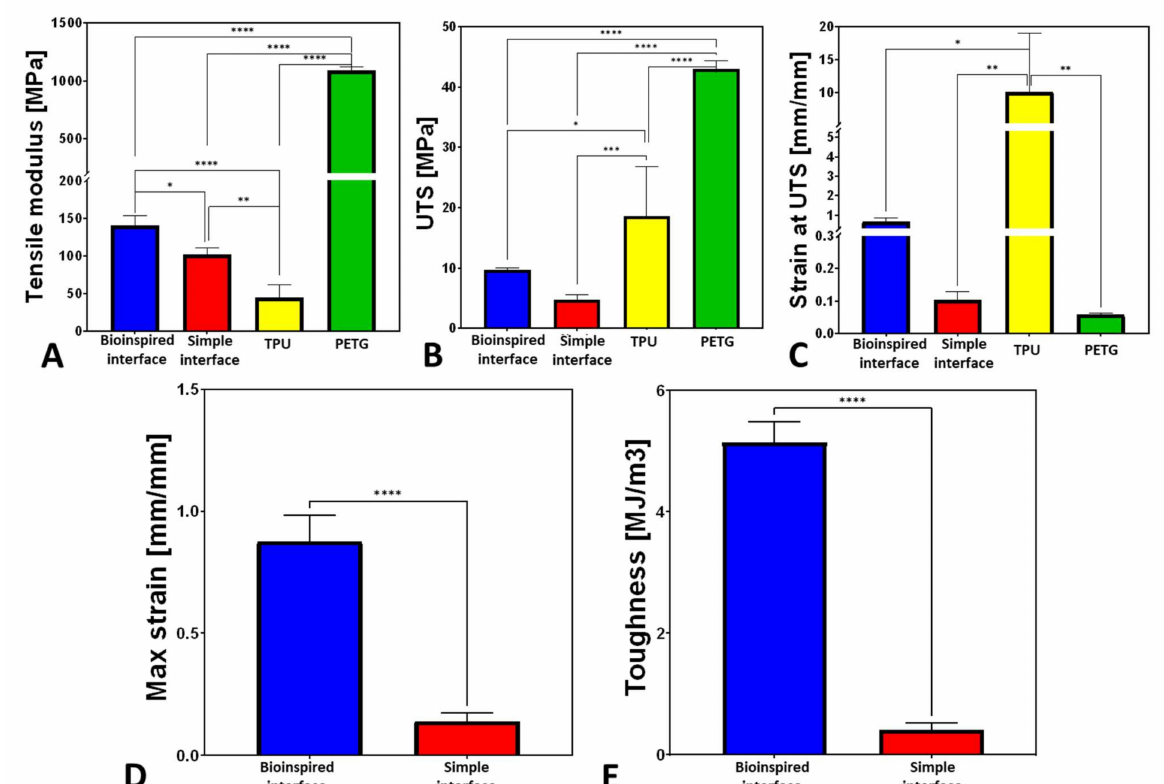
Figure 6. Mechanical properties of 3D-printed PETG, TPU, and combined samples with simple and bioinspired interfaces: ( A ) tensile modulus; ( B ) UTS; ( C ) strain at UTS; ( D ) maximal strain; ( E ) tensile toughness. Note: * stands for p < 0.05, ** for p < 0.005, *** p < 0.0005, and **** p <